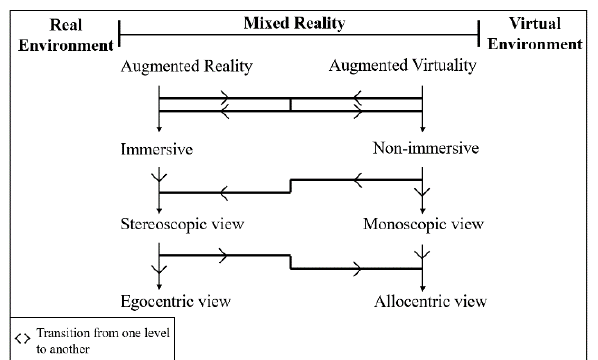
Figure 1. Inspired from Milgram’s virtuality continuum. Arrows represent the transition from one level to another (Milgram,